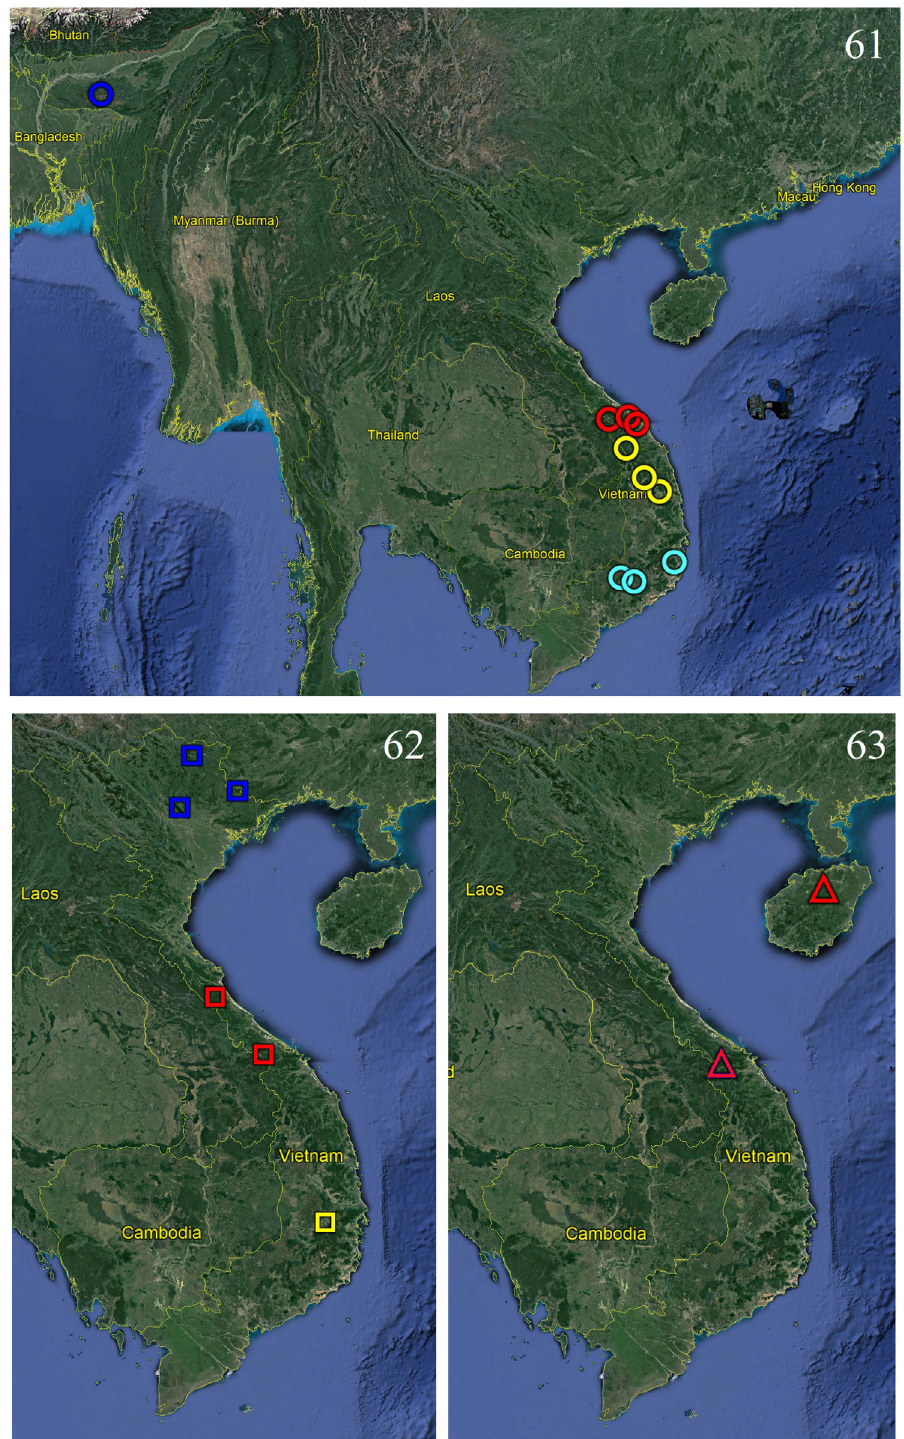
Figs 61–63. Distribution maps of species of Chlorogomphus Selys, 1854. 61 . Distribution map of C. fraseri St. Quentin, 1936 (dark blue circle), C. aritai Karube, 2013 (red circles), C. hoaian sp. nov. (yellow circles) and C. caloptera Karube, 2013 (light blue circles). 62 . Distribution map of C. auratus Martin, 1910 (blue squares), C. canhvang Kompier & Karube, 2018 (red squares) and C. vani sp. nov. (yellow square). 63 . Distribution map of C. gracilis Wilson & Reels, 2001 (red triangles) in Vietnam and